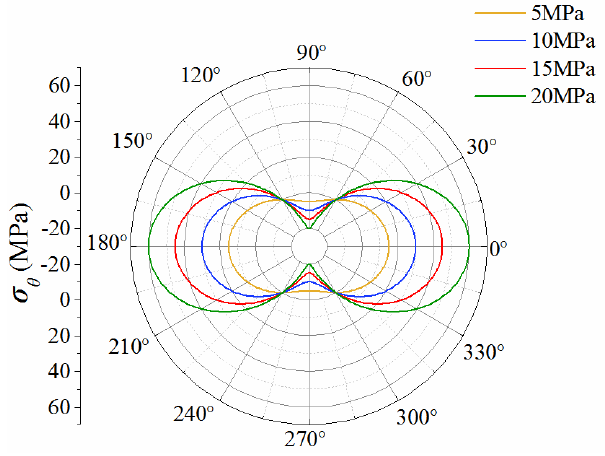
Figure 11. The distribution of circumferential stress around the discharge channel under the static loading applied in Group I.